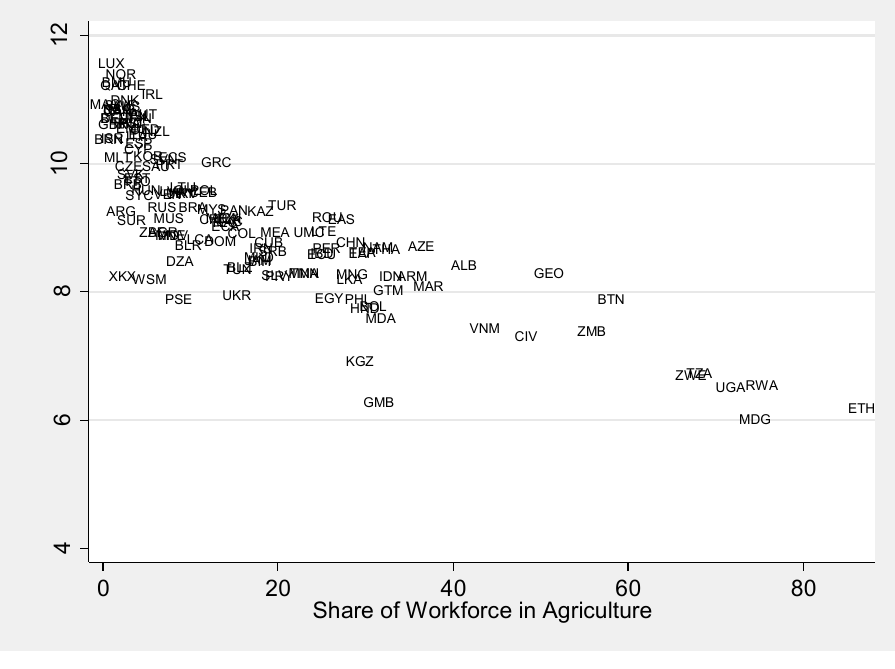
Figure 1. Correlation between GDP per capita and the Share of the Workforce in Agriculture, by coun- try,